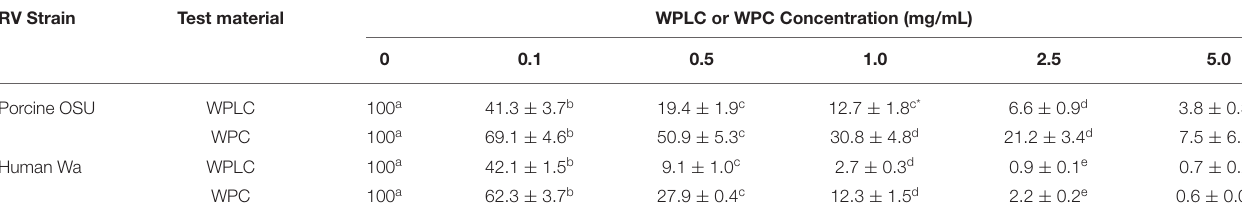
TABLE 1 | Porcine RV OSU and Human RV Wa Infectivity (%) in MA104 Cells modulated by co-incubation with either WPLC or WPC. RV Strain